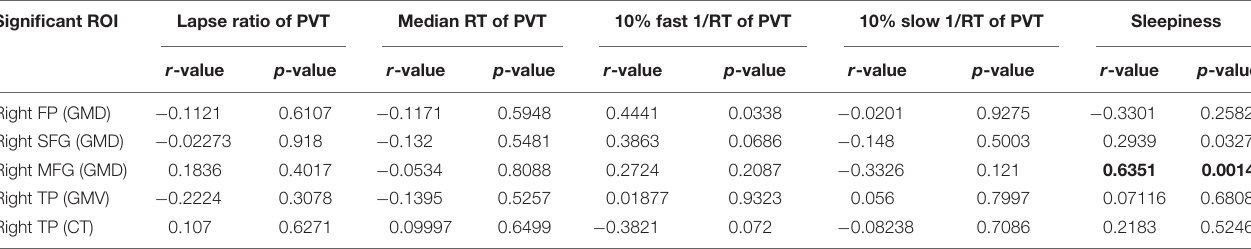
FIGURE 3 | Significant decrease of gray matter volume (GMV) and cortical thickness (CT) between after SD state. The only significant brain region of GMV (A,B) and CT (C,D) was the right temporal pole (TP). There were no regions that exhibited significant change of GMV or CT after SD. RW, rested wakefulness; SD, sleep deprivation. TABLE 2 | Relationship between brain structure changes and behavioral